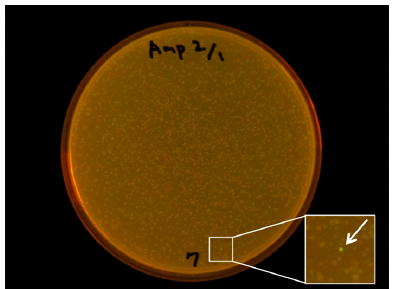
Figure 4. Expression cloning of fluorescent protein from Scolionema suvaense with the frame-insensitive pRSET-TriEX vector. Screening of 3658 colonies in total was performed and one green fluorescent colony was found only on the plate, shown here in the bottom right corner.